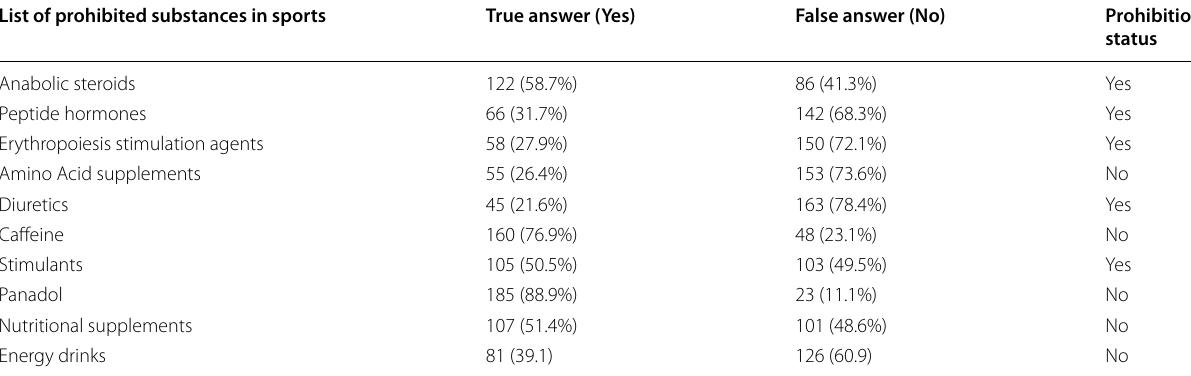
Table 2 Knowledge of list of prohibited substances (PESs) in sports among participants List of prohibited substances in sports Anabolic